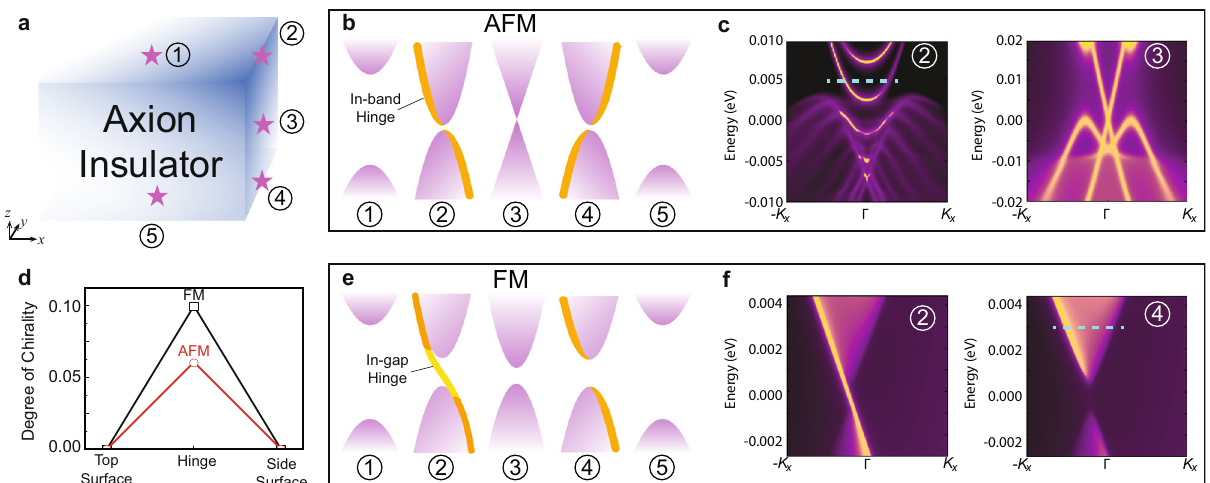
Fig. 3 Spectra of surface and hinge states. a Schematic of an axion insulator, with its top surface, top hinge, side surface, bottom hinge, and bottom surface marked as ① - ⑤ , respectively. b , e Schematic of the topological band spectra at spots ① - ⑤ for b AFM and e FM MnBi 2 Te 4 . The orange and yellow lines denote in-band hinge and in-gap hinge states, respectively. c , f The hinge and the side surface LDOS of c AFM MnBi 2 Te 4 ( ② and ③ ) and f FM MnBi 2 Te 4 ( ② and ④ ). d The degree of chirality of the in-band hinge states with the Fermi level marked by the blue dashed lines in c and f .